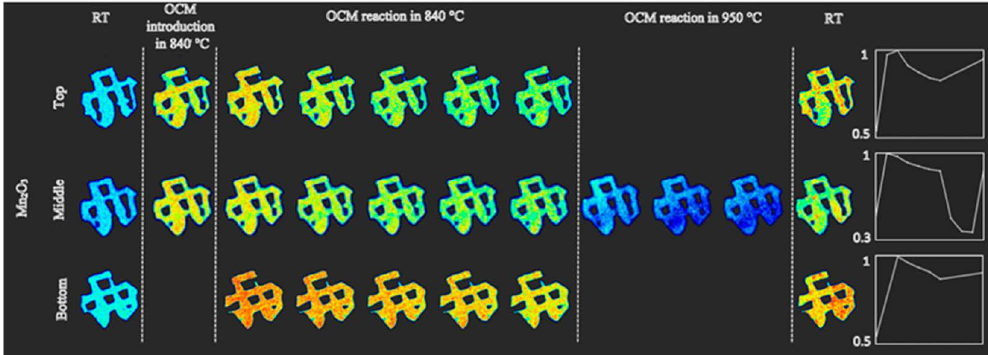
Figure 6. In-situ studies of 3D printed Mn–Na–W/SiO 2 catalysts from JM; spatial distribution of the active catalyst component (Mn 2 O 3 -phase) on the micrometer length scale across silica support under different oxidative coupling of methane (OCM) operating conditions with a CH 4 :O 2 :N 2 ratio of 4:1:4 at 840 ◦ C for a duration of 5.5 h and at 950 ◦ C for ca. 1 h (note that top and bottom positions were not measured).